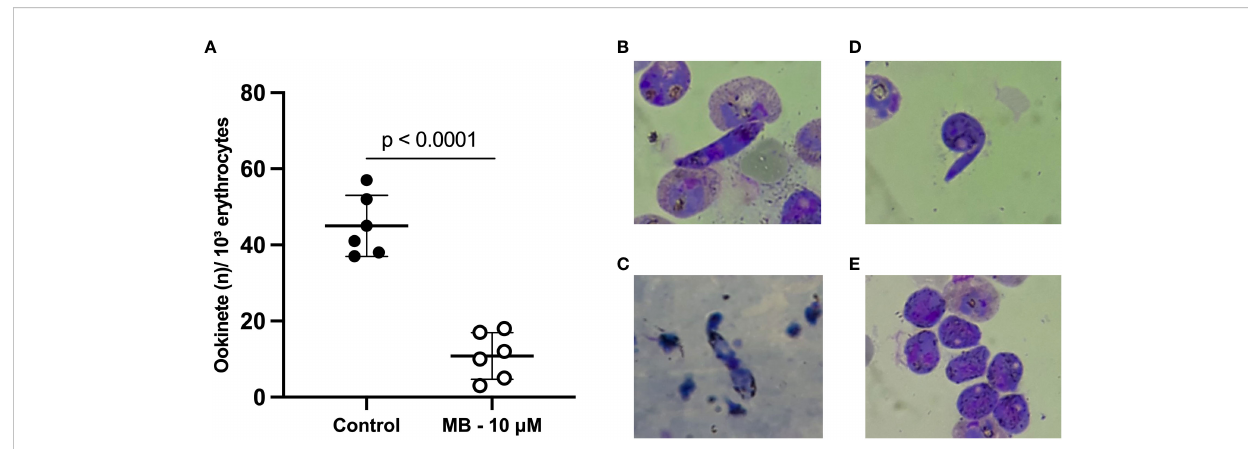
FIGURE 1 Methylene blue activity in the ex vivo Plasmodium vivax ookinete assay. Mean number of ookinetes per 10³ erythrocytes found in stained thin smears from three independent assays (isolates) tested in duplicate after 24 hours of P. vivax zygote culture at 25°C in the presence or absence (control group) of methylene blue at 10 μM. Each circle represents one replicate (A) . Photos show thin smears stained with Panoptic staining kit after 24 hours of P. vivax zygote culture at 24°C. (B, C) demonstrate mature ookinetes in the absence of MB (control group). (D, E) demonstrate only immature sexual forms – zygotes in the presence of MB at 10 μM. P-value (p < 0.0001) was calculated using the unpaired t